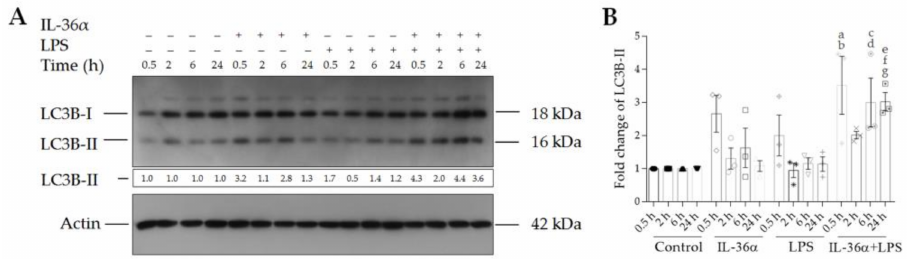
Figure 3. IL-36 α and LPS cooperatively increase the level of LC3B-II. ( A ) Western blot analysis showing the kinetics of endogenous LC3B-II expression. Total protein was isolated from controls (lanes 1–4), IL-36 α -treated cells (lanes 5–8), LPS-treated cells (lanes 9–12), and cells treated with IL-36 α -LPS combination (lanes 13–16) at the indicated time points. Samples were resolved on SDS-PAGE and transferred to PVDF filters. After incubation with the corresponding antibody, the levels of LC3B-I and LC3B-II were determined with a chemiluminescence detection system. Band intensities were quantified with ImageJ software. The ratios of the protein levels measured at 0.5, 2, 6, and 24 h were compared to the corresponding time point controls and expressed as fold change (shown below each lane). The results are representative of three independent experiments. ( B ) The values on the bar graph denote the means ± SD of the results of three independent experiments. p values were calculated by the ANOVA test with the Sidak post-test. a p < 0.01 vs. the 0.5-h time point control, b p < 0.05 vs. the 0.5-h time point LPS, c p < 0.05 vs. the 6-h time point control, d p < 0.01 vs. the 6-h time point LPS, e p < 0.05 vs. the 24-h time point control, f p < 0.01 vs. the 24-h time point IL-36 α , and g p < 0.01 vs. the 24-h time point